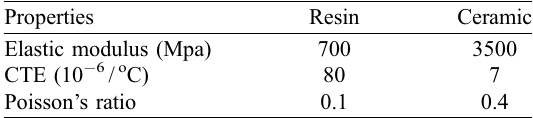
Table 1. Material properties used in the topology